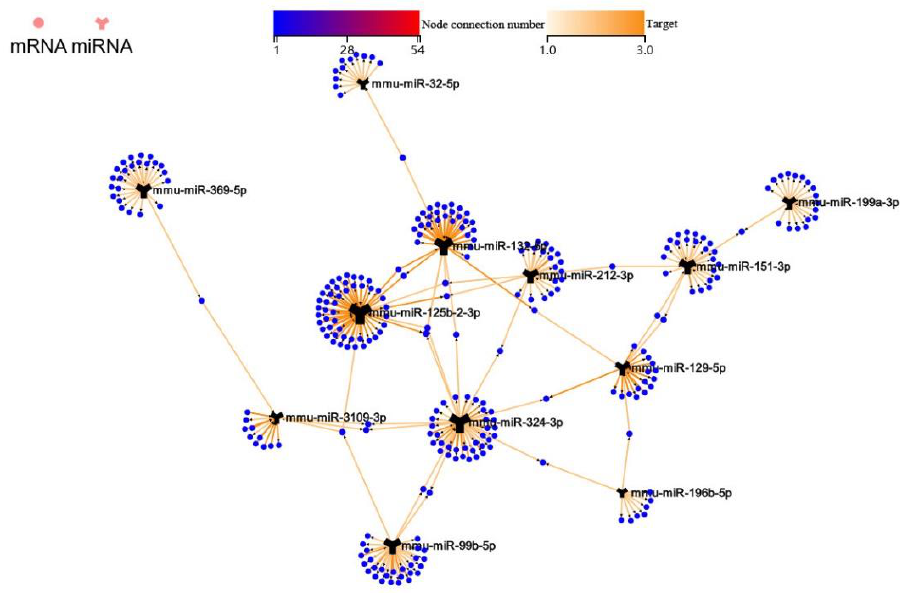
Figure 6. The correlation between the 12 stably enriched DEmiRs and their target mRNAs. The association network of these DEmiRNAs and their target mRNAs, indicated that miR-132-5p, miR-324-3p, and miR-125b-2-3p were the most correlated miRNAs sharing two common target genes with each other.